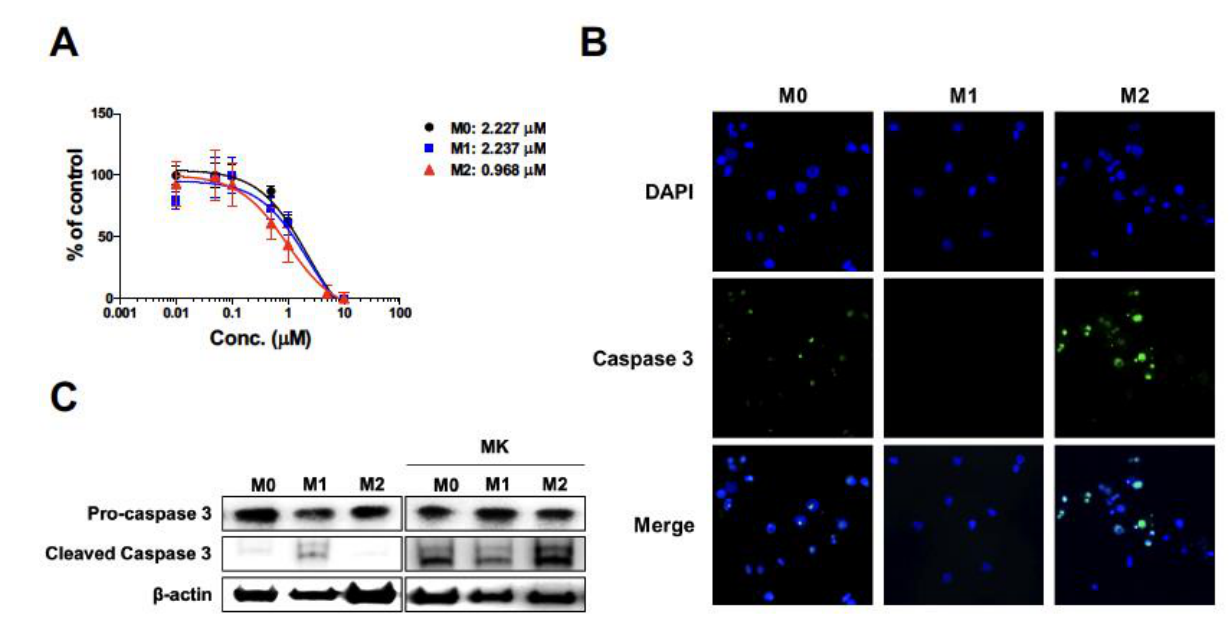
Figure 3. Apoptosis of THP-1-derived M2 macrophages by melittin – dKLA. Human monocytes (THP-1) were treated with 100 nM PMA for 24 h and cultured with the following: 100 ng/mL LPS and 20 ng/mL rhIFN- γ for M1 macrophage differentiation ; 20 ng/mL rhIL-4 and 20 ng/mL rhIL-13 for M2 macrophage differentiation. ( A ) Macrophages were treated with melittin – dKLA by concentrations from 0.01 μM to 10 μM. Cell viability of macrophages was measured by CCK -8 assay. Data are presented as the means ± SD. ( B , C ) Macrophages were treated with melittin –dKLA (1 μM). Expression of caspase 3 was observed by fluorescence microscopy ( B ) and Western blot ( C ), MK: melittin – dKLA.